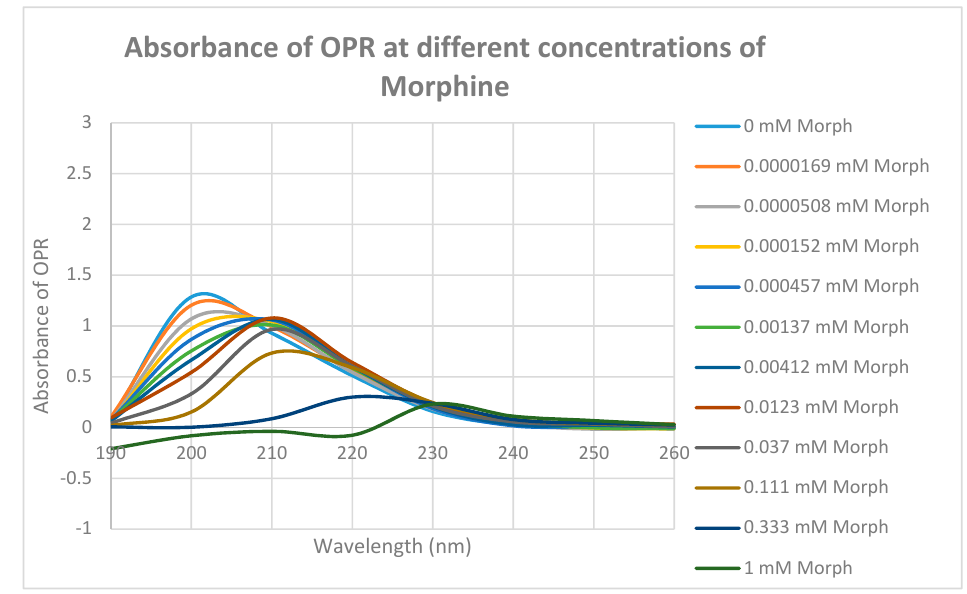
Figure 17. UV spectra of mu opioid receptor (OPR) with serial additions of morphine. Note the very significant differences between these spectra and those in Figures 10 and 11.